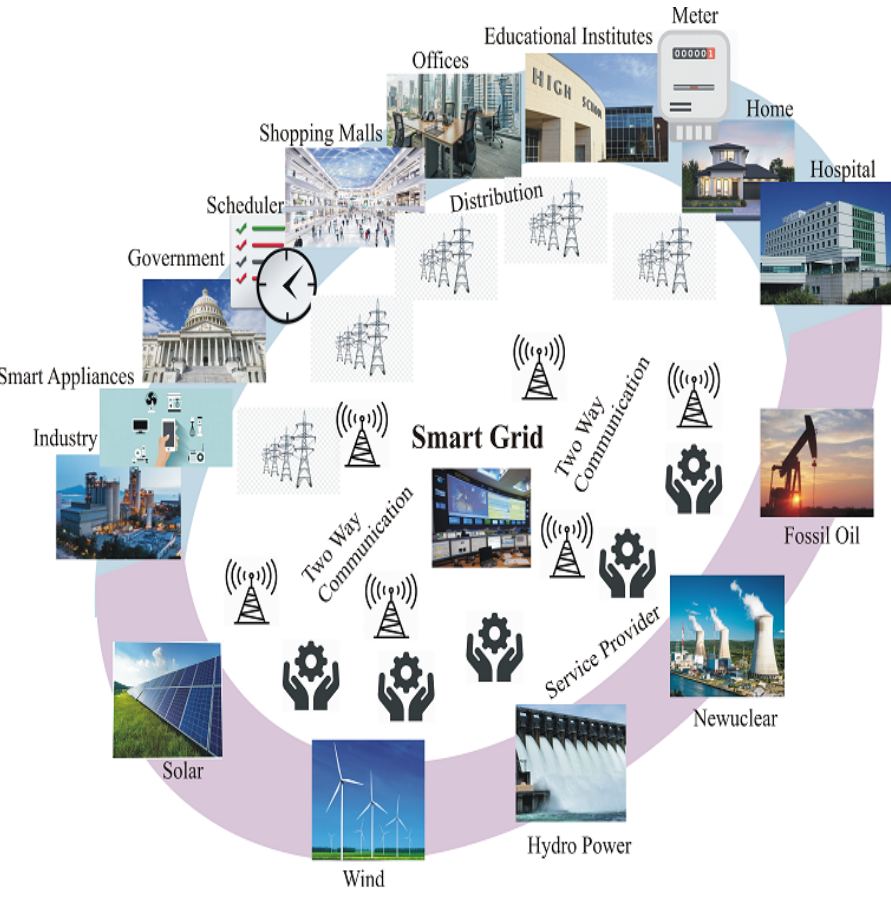
Figure 1. Model of a Smart